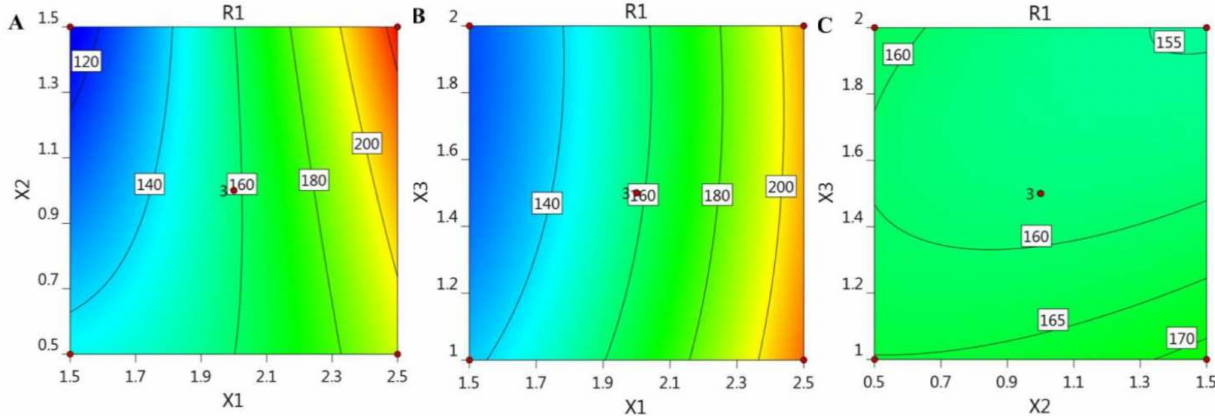
Figure 1. 2D contour graphs demonstrating the influence of the independent factors ( A ) X 1 and X 2 ,